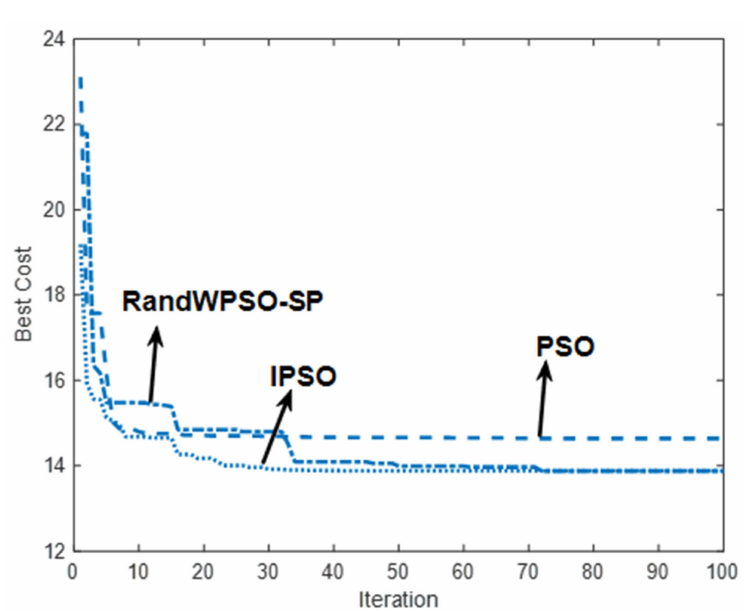
Figure 7. RDS-PSO iteration.